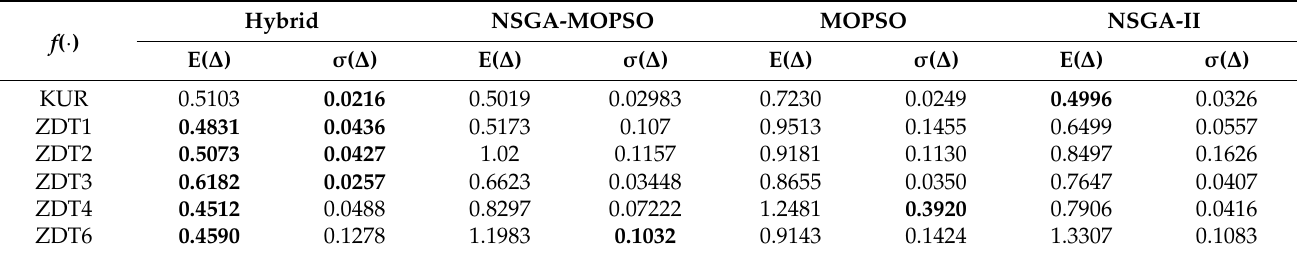
Table 4. Statistical results of diversity